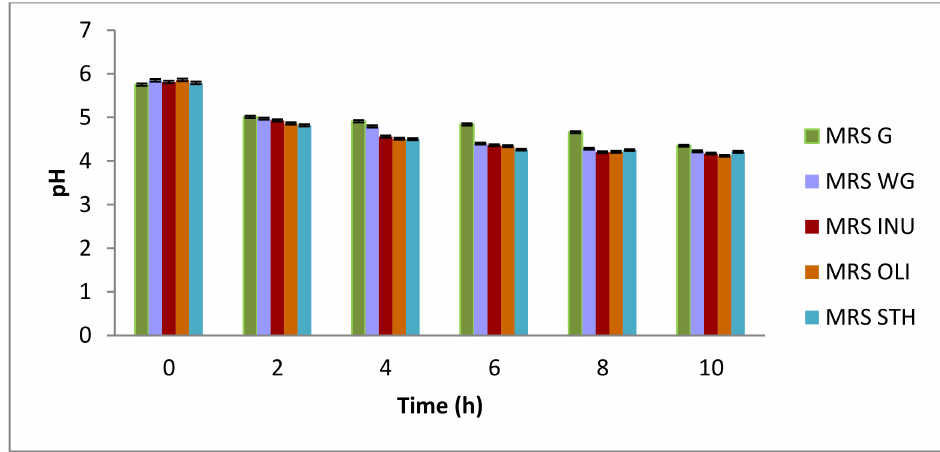
Figure 1. Changing of pH as a consequence of increasing cellular biomass in modified culture media. Each bar presents the mean of three replicates ± standard deviation ( MRS g-culture medium made according to the original recipe, glucose culture medium, MRS WG-culture medium without carbon source, glucose-free culture medium, MRS INU-culture medium with inulin as a carbon source, MRS OLI-culture medium with oligofructose as a carbon source, oligofructose culture medium, MRS STH-culture medium with potato starch as a carbon source, starch culture